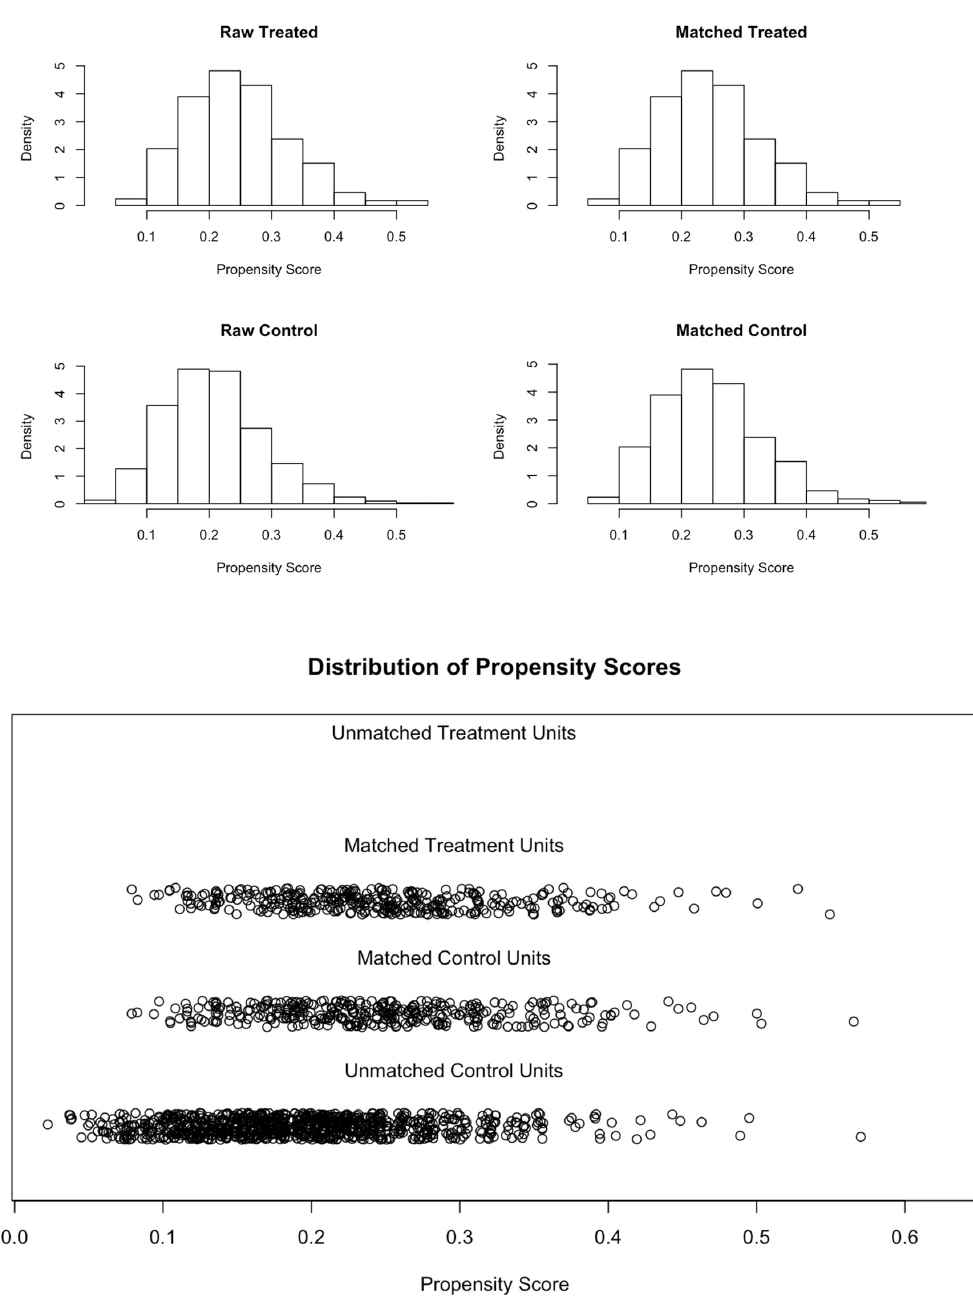
Figure 2. Propensity scores in the treated and control